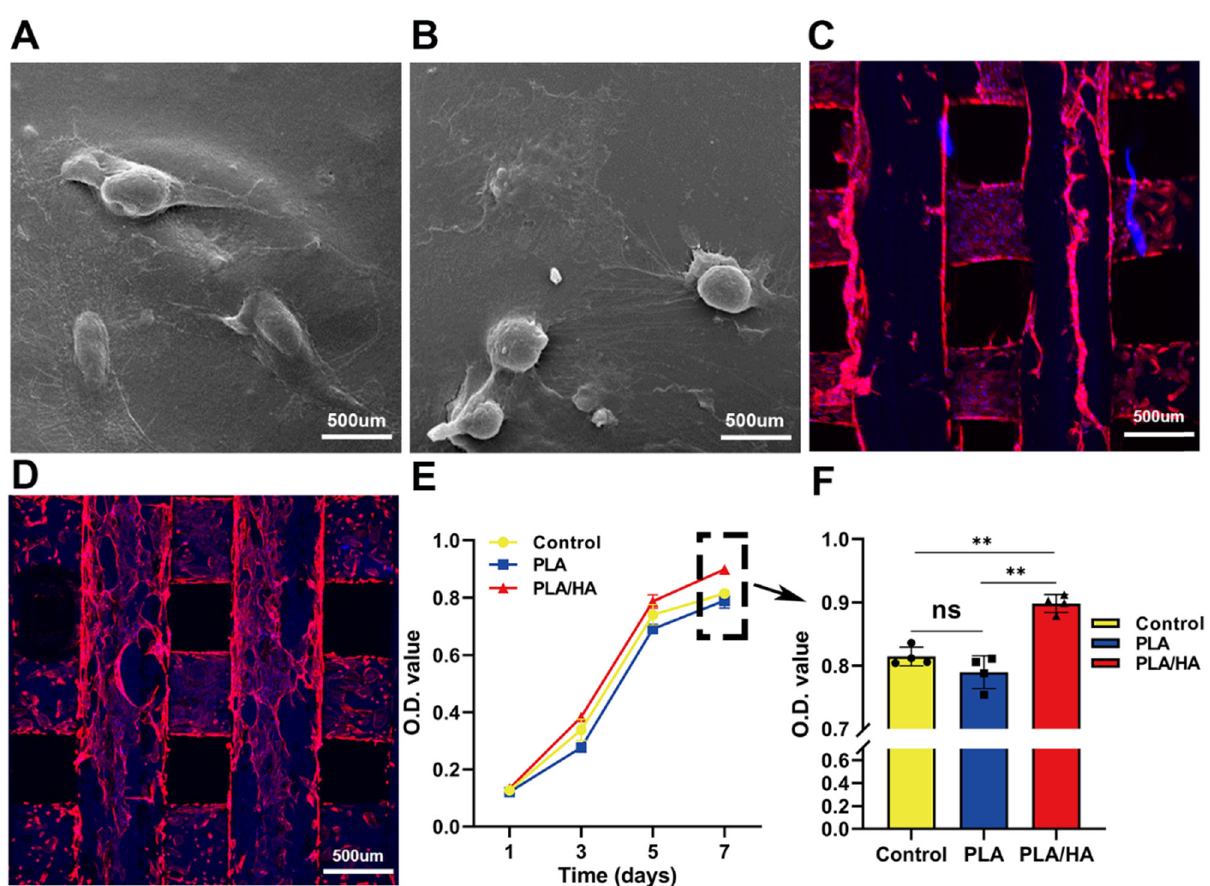
Fig. 4 Cytocompatibility tests of the scaffolds. Electronic microscopy scans of USCs on PLA ( A ) and PLA/HA ( B ) scaffolds. The cytos- keleton was investigated by laser confocal microscopy ( C PLA